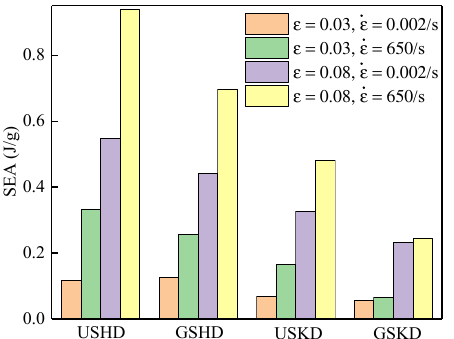
Figure 7. Specific energy absorption of the four structures at ε = 0.03 and ε = 0.08.